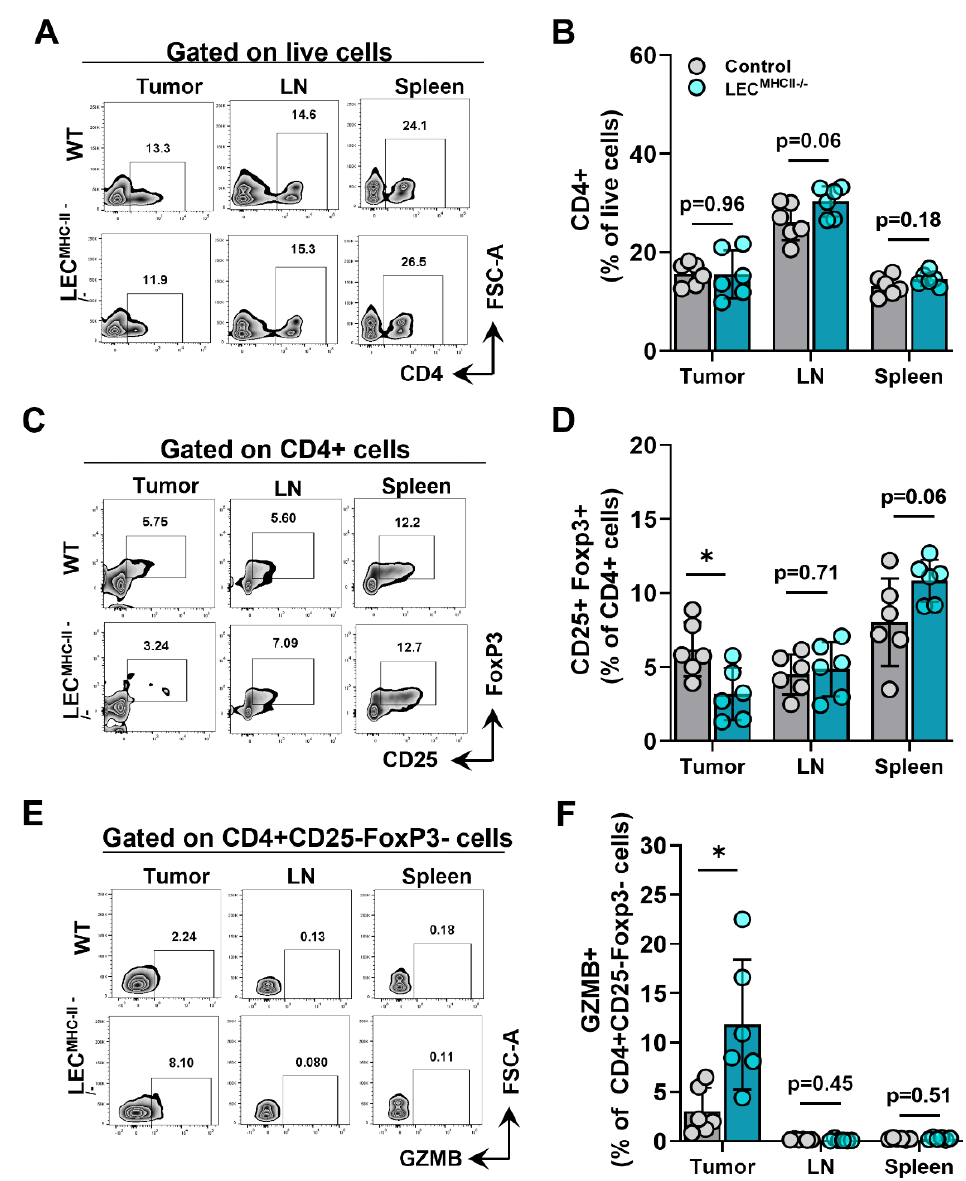
Figure 6. Attenuated tumor growth in LEC-specific MHC-II knockout background is associated with increased number of effector CD4+ TILs and decreased number of T regulatory lymphocytes. ( A ) Representative FACS plots and ( B ) quantification of CD4+cells in the tumor, tumor draining lymph node, and spleen in WT and LEC MHC II − / − mice bearing B16F10-OVA at 12 days post tumor inoculation. ( C ) Representative FACS plots and ( D ) quantification of CD4+CD25+FoxP3+cells in the tumor, tumor draining lymph node, and spleen in WT and LEC MHC II − / − mice bearing B16F10-OVA at 12 days post tumor inoculation. ( E ) Representative FACS plots and ( F ) quantification of GZMB+CD4+CD25-FoxP3- in the tumor, tumor draining lymph node, and spleen in WT and LEC MHC II − / − mice bearing B16F10-OVA at 12 days post tumor inoculation. Statistical significance assessed using unpaired student’s t test on data from at least 5 biological replicates; error represented as SD. *, p <